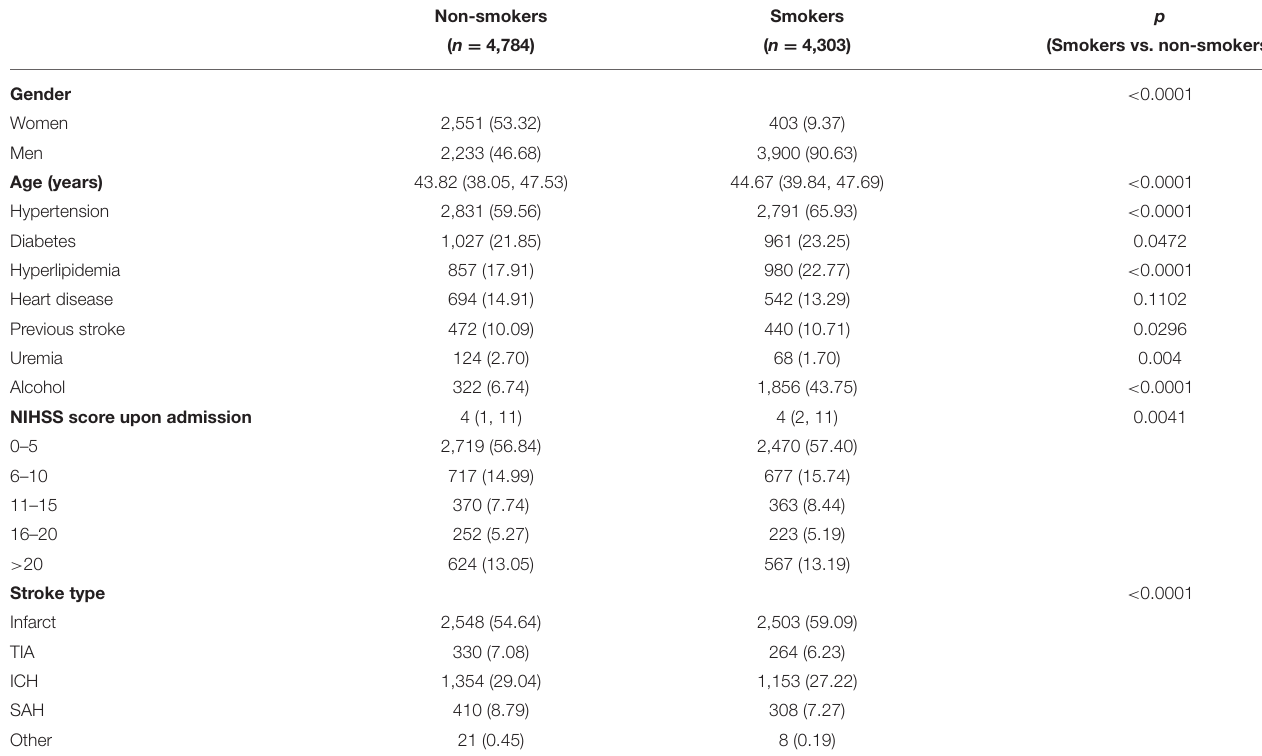
TABLE 1 | Baseline characteristics of smokers/non-smokers and stroke risk factors, n